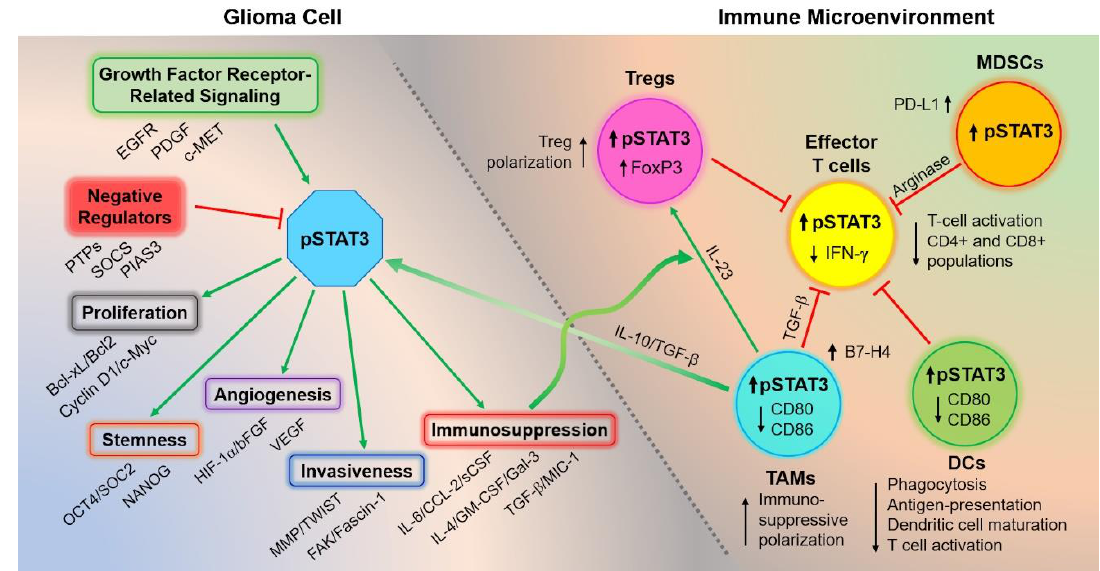
Figure 2. STAT3 pathway activation represents a focal point of tumorigenesis and immune escape. Aberrant STAT3 activation occurs as a result of several potential upstream and downstream regulatory events including growth factor receptor signaling (e.g., epidermal growth factor (EGFR), platelet-derived growth factor (PDGF), and c-MET)), inhibition of negative regulators of STAT3 (e.g., protein tyrosine phosphatases (PTPs), suppressors of cytokine signaling (SOCS), and protein inhibitor of activated STAT 3 (PIAS3)), and microenvironmental cytokine crosstalk between immune and glioma cells. STAT3 activation transcriptionally upregulates key genes involved in proliferation, stem cell self-renewal, angiogenesis, invasiveness, and formation of the immune microenvironment. The balance of microenvironmental cytokines favors the infiltration of immunosuppressive immune cell populations, including myeloid derived suppressor cells (MDSCs), tumor-associated macrophages/microglia (TAMs), and Tregs. These cytokines activate STAT3 signaling within immune cell populations to increase immunosuppressive macrophage polarization, decreased antigen presentation, and decreased T cell activation.